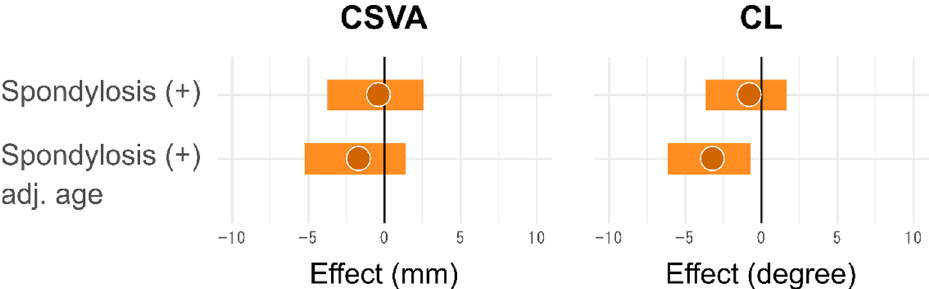
Figure 1. Impact of cervical spondylosis on cervical alignment parameters. Note: Bands represent 95% confidence interval. Abbreviations: CSVA, cervical sagittal vertical axis; CL, cervical lordosis; adj. age, multivariate analysis adjusted by age. T1S minus CL displayed a significant moderate positive correlation with CSVA in both genders (Pearson correlation coefficient: 0.49 for males and 0.48 for females, both p < 0.01) (Figure 2). Only in males, however, did both CSVA and CL show mild positive correlations with SVA independently of age (Figure 3 and Table 3).